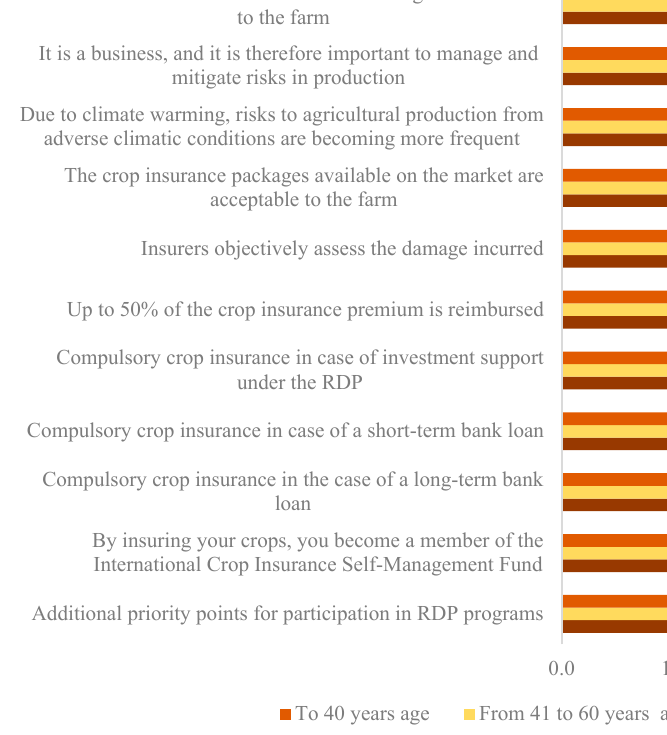
Figure 5. Reasons for farmers of different ages to take crop insurance.